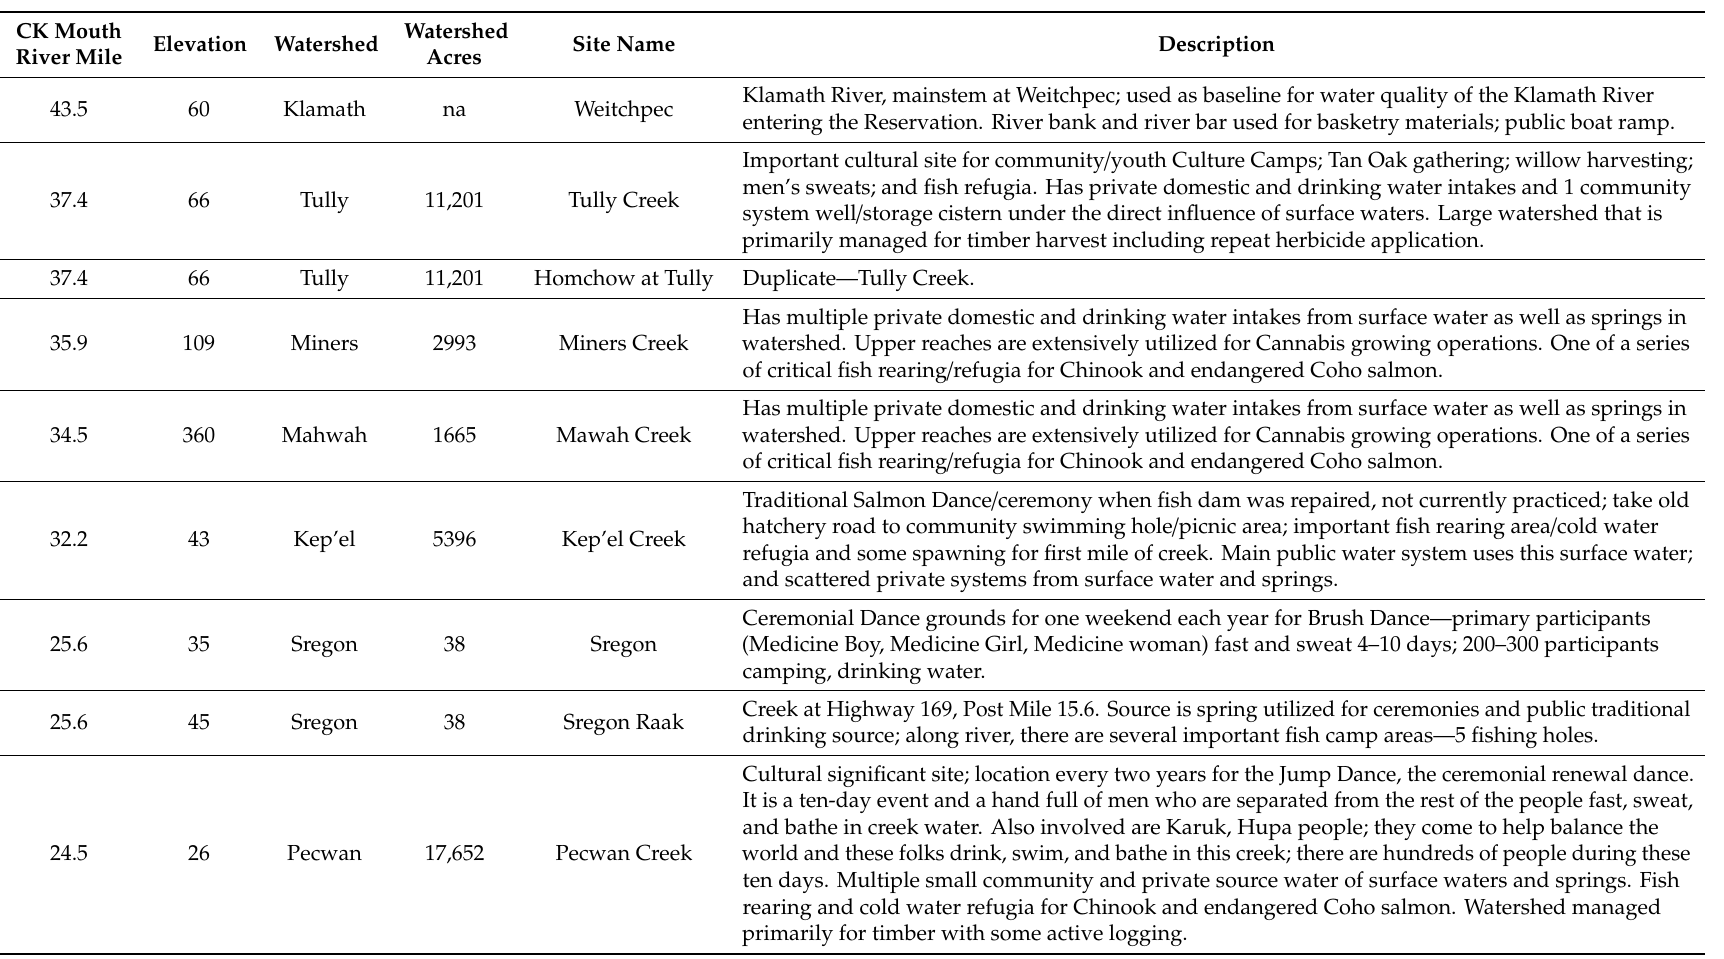
Table 2. Klamath River and tributary water sampling